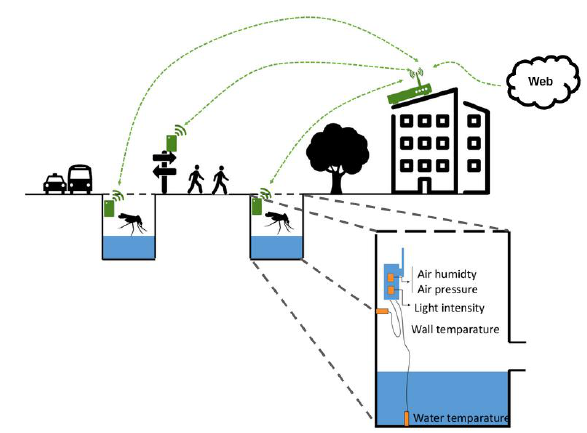
Figure 1. The system’s overview.